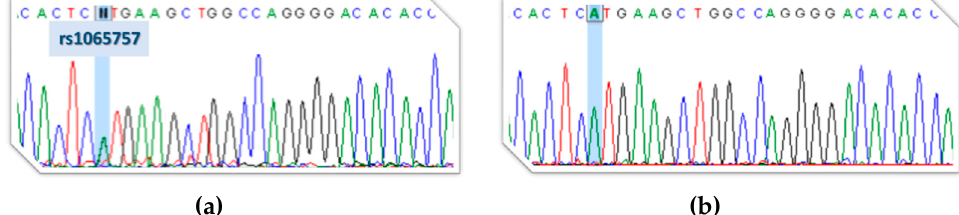
Figure 3. Indirect proof of principle on c.1213+5G>T [IVS6+5G>T] pathogenicity. Electropherograms highlighting the rs1065757 polymorphism (G>A) in the proband’s father (Pf) gDNA (heterozygous;